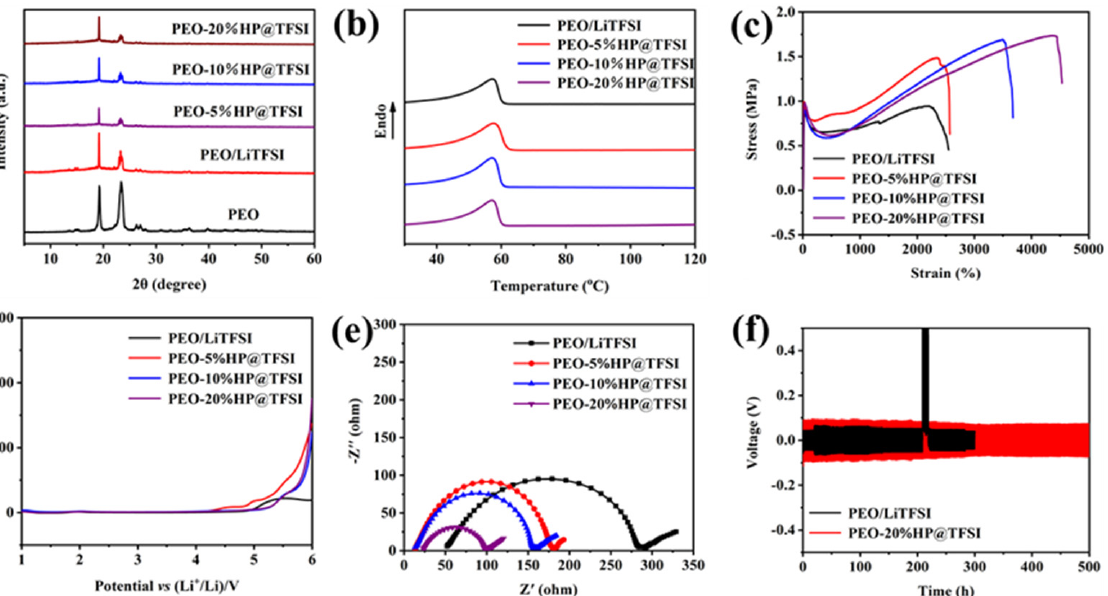
Table 1. DSC results of polymer electrolyte.